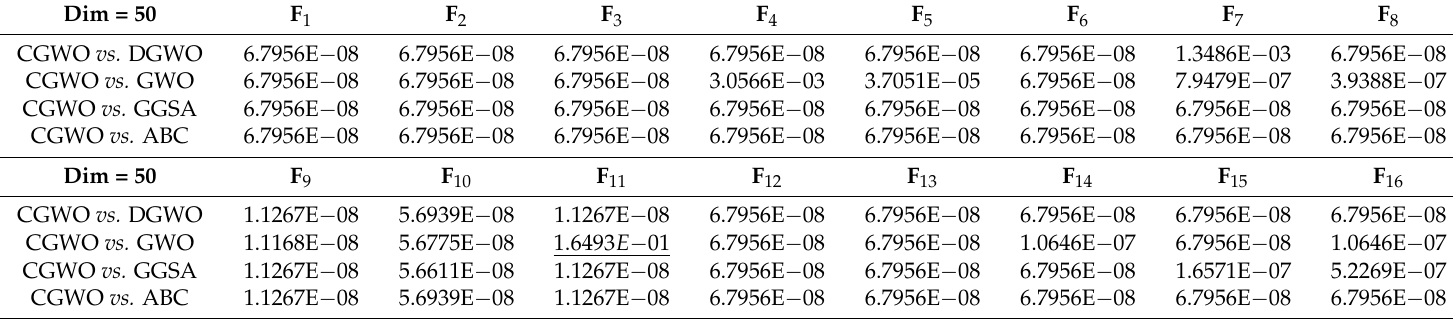
Table 8. p -values produced by Wilcoxon rank-sum test comparing CGWO vs. DGWO, GWO, GGSA, and ABC at Dim = 50 ( p ě 0.05 have been underlined).